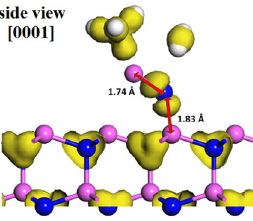
Figure 7. The difference charge density of the initial growth modeling on AlN(0001) surface after the desorption path (5). Yellow regions represent larger charge